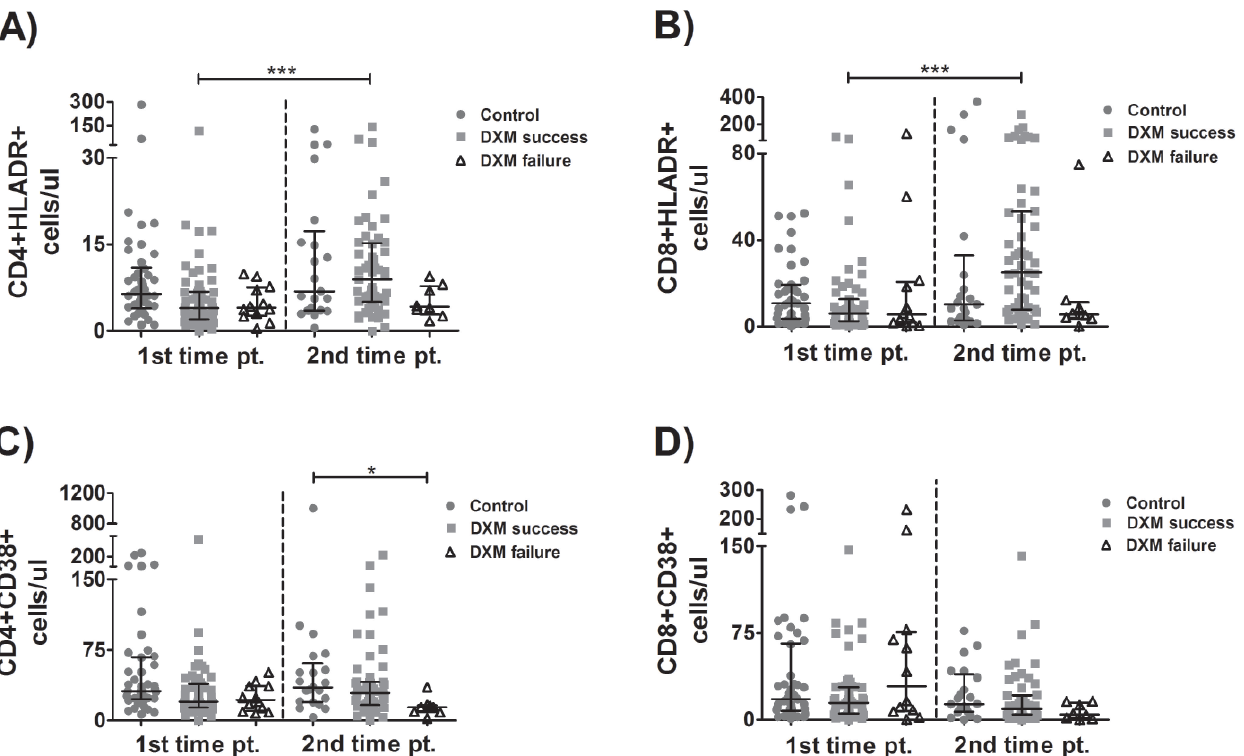
Figure 3. Kinetics of activated T-lymphocytes. Lymphocyte sub-populations were evaluated over time in blood samples from patients with COVID-19 who received (or not) treatment with dexamethasone. Activated CD4+ ( A , C ) T-lymphocytes and activated CD8+ ( B , D ) T-lymphocytes were determined with flow cytometry. Multiple comparisons were made using Kruskal–Wallis with Dunn’s post-hoc tests. Comparisons between the two groups were made with Student’s T -test or the Mann–Whitney U-test as indicated. DXM: Dexamethasone. p -values < 0.05 were considered significant. * p < 0.05, *** p < 0.001.